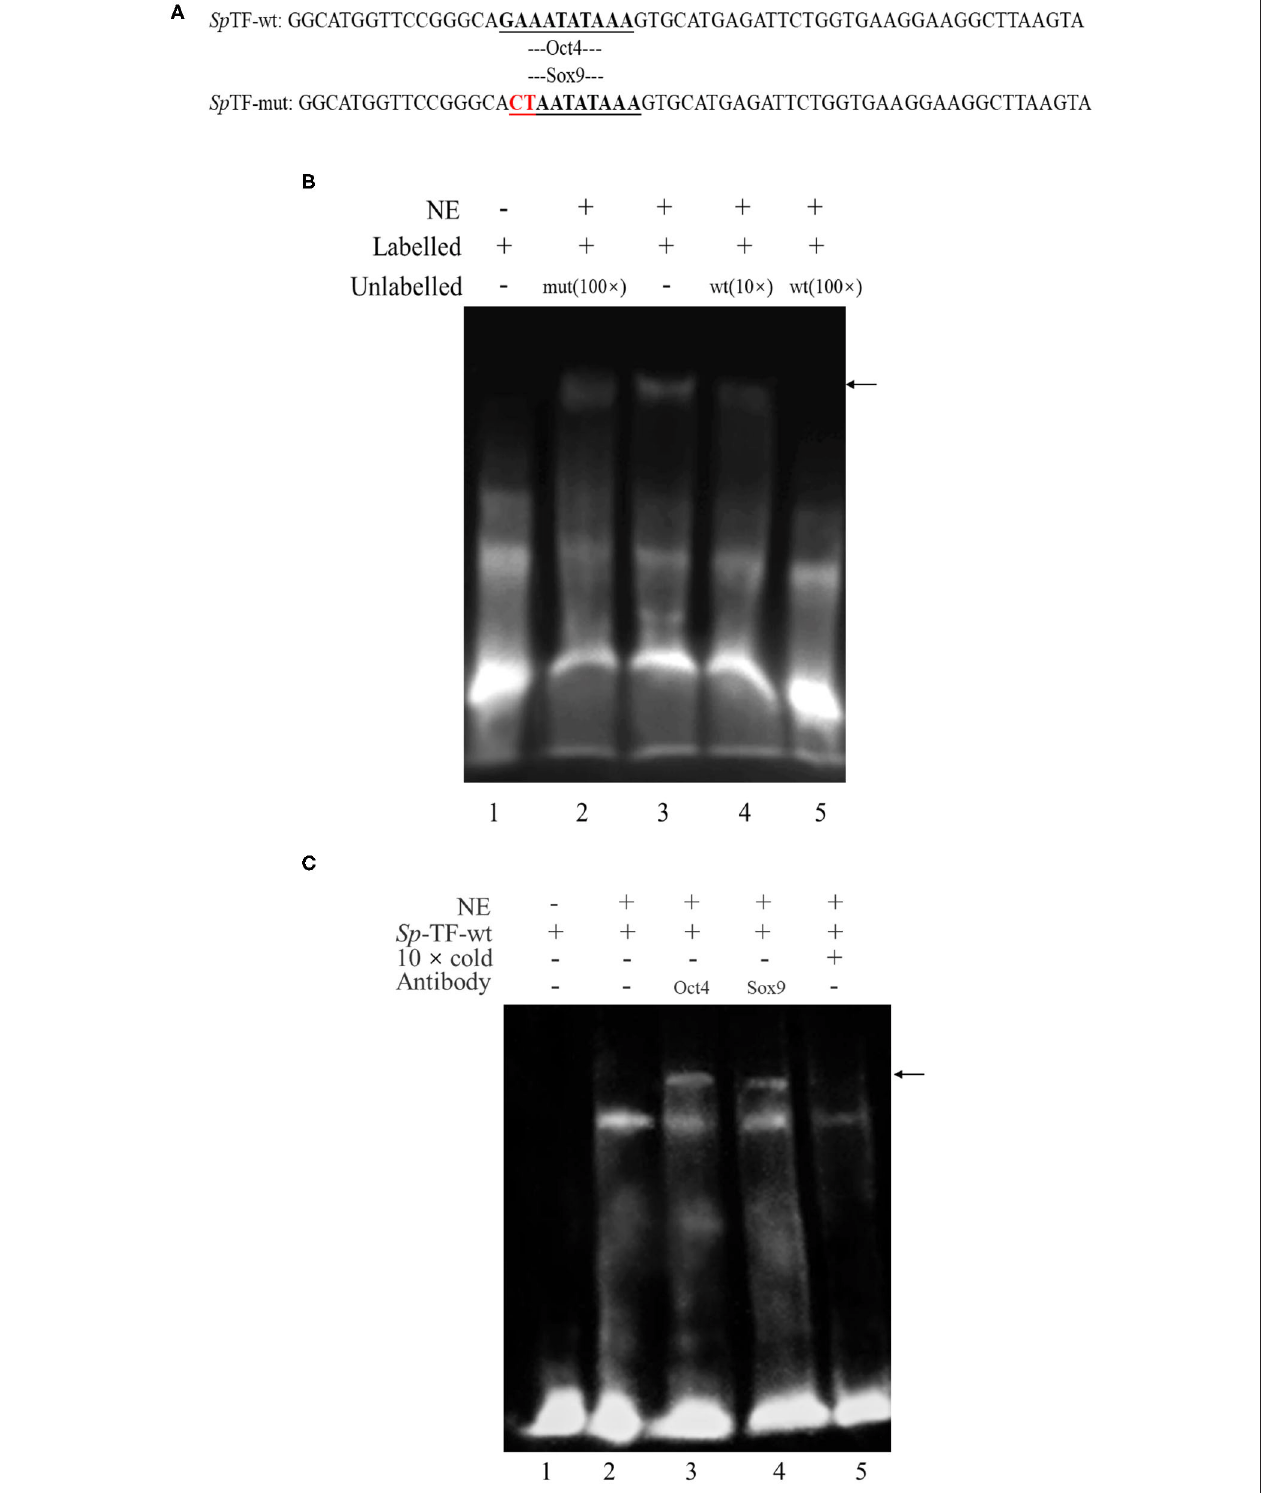
FIGURE 1 | Electrophoretic mobility shift assay (EMSA) analysis of the binding of Oct4 and Sox9 to specific CRE in the SpVih promoter. (A) The sequence of the wild-type probe and the mutant probe. (B) EMSA. Biotin-labeled and unlabeled double-stranded DNA probes containing complete CRE of Oct4 and Sox9 as well as mutated probes that mutated the binding sites of Oct4 and Sox9 were prepared. Lane 1 was the free probe. The Sp TF-wt could combine with the eyestalk nuclear